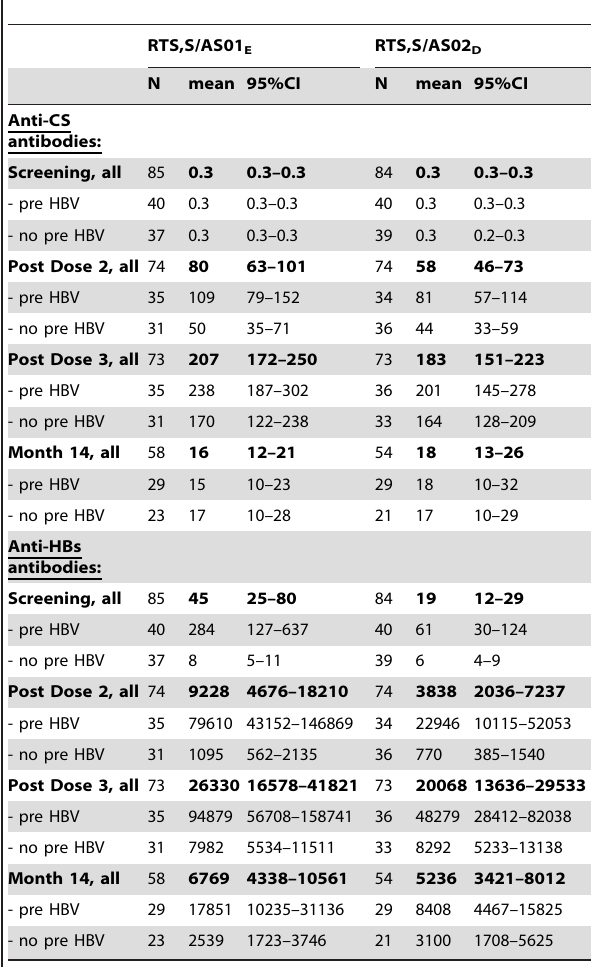
Values are geometric mean titers and 95% confidence intervals expressed in EU/ mL. N values for pre HBV and no pre HBV do not match up to the total due to some missing values on the pre HBV status.